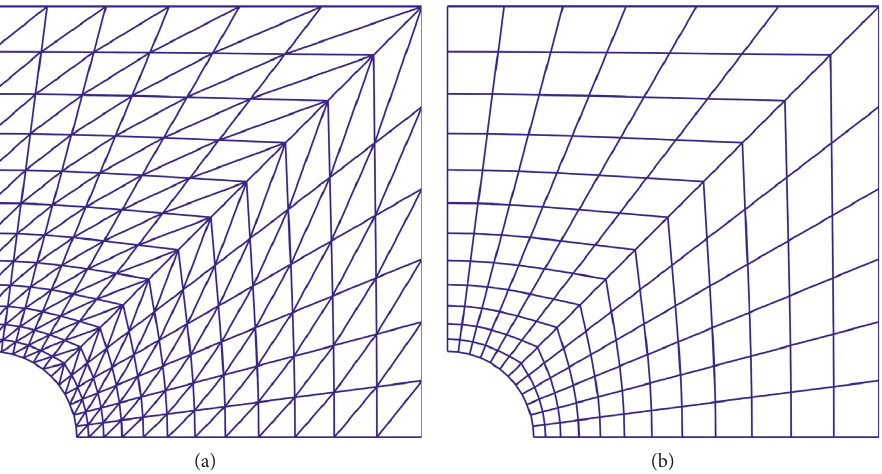
Figure 14: Domain discretization of the infinite plate with a circular hole using triangular and quadrilateral elements.